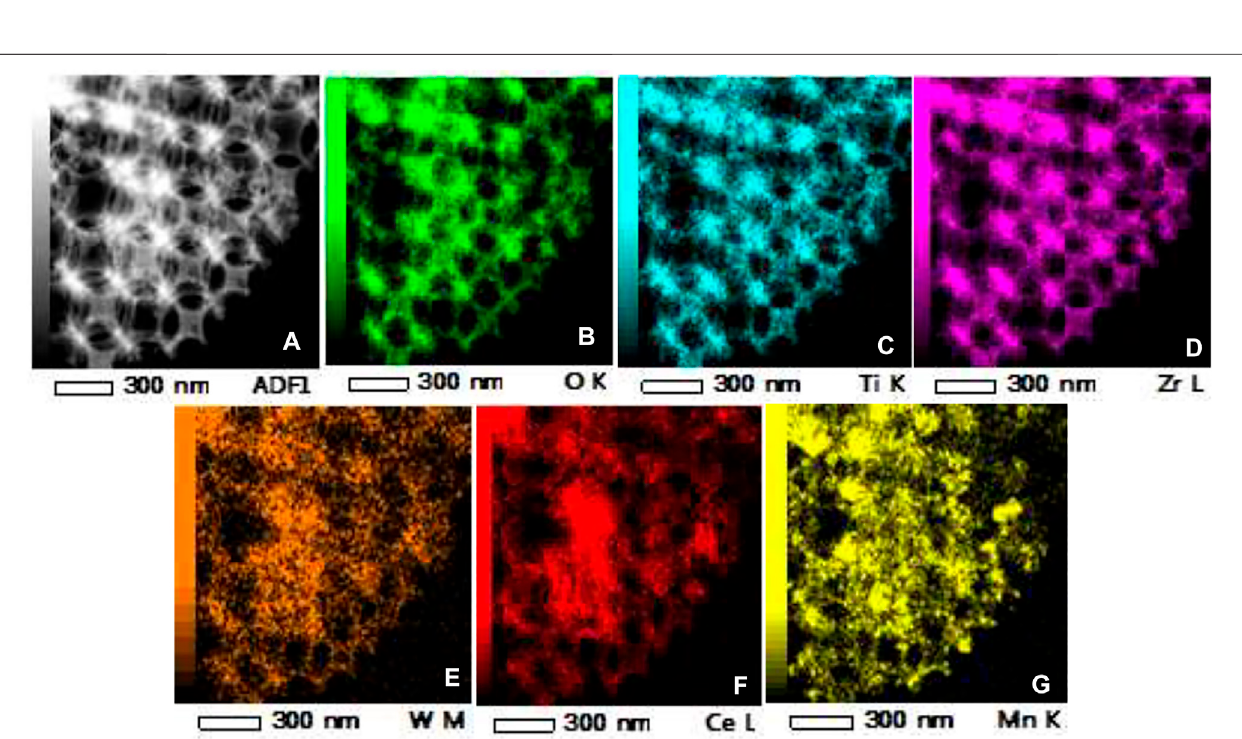
FIGURE 5 | HAADF-STEM image and EDS elemental mappings of W 1 CeMnO δ /3DOM ZrTiO 4 . (A) STEM; (B – G) EDS mappings of O, Ti, Zr, W, Ce, and Mn.